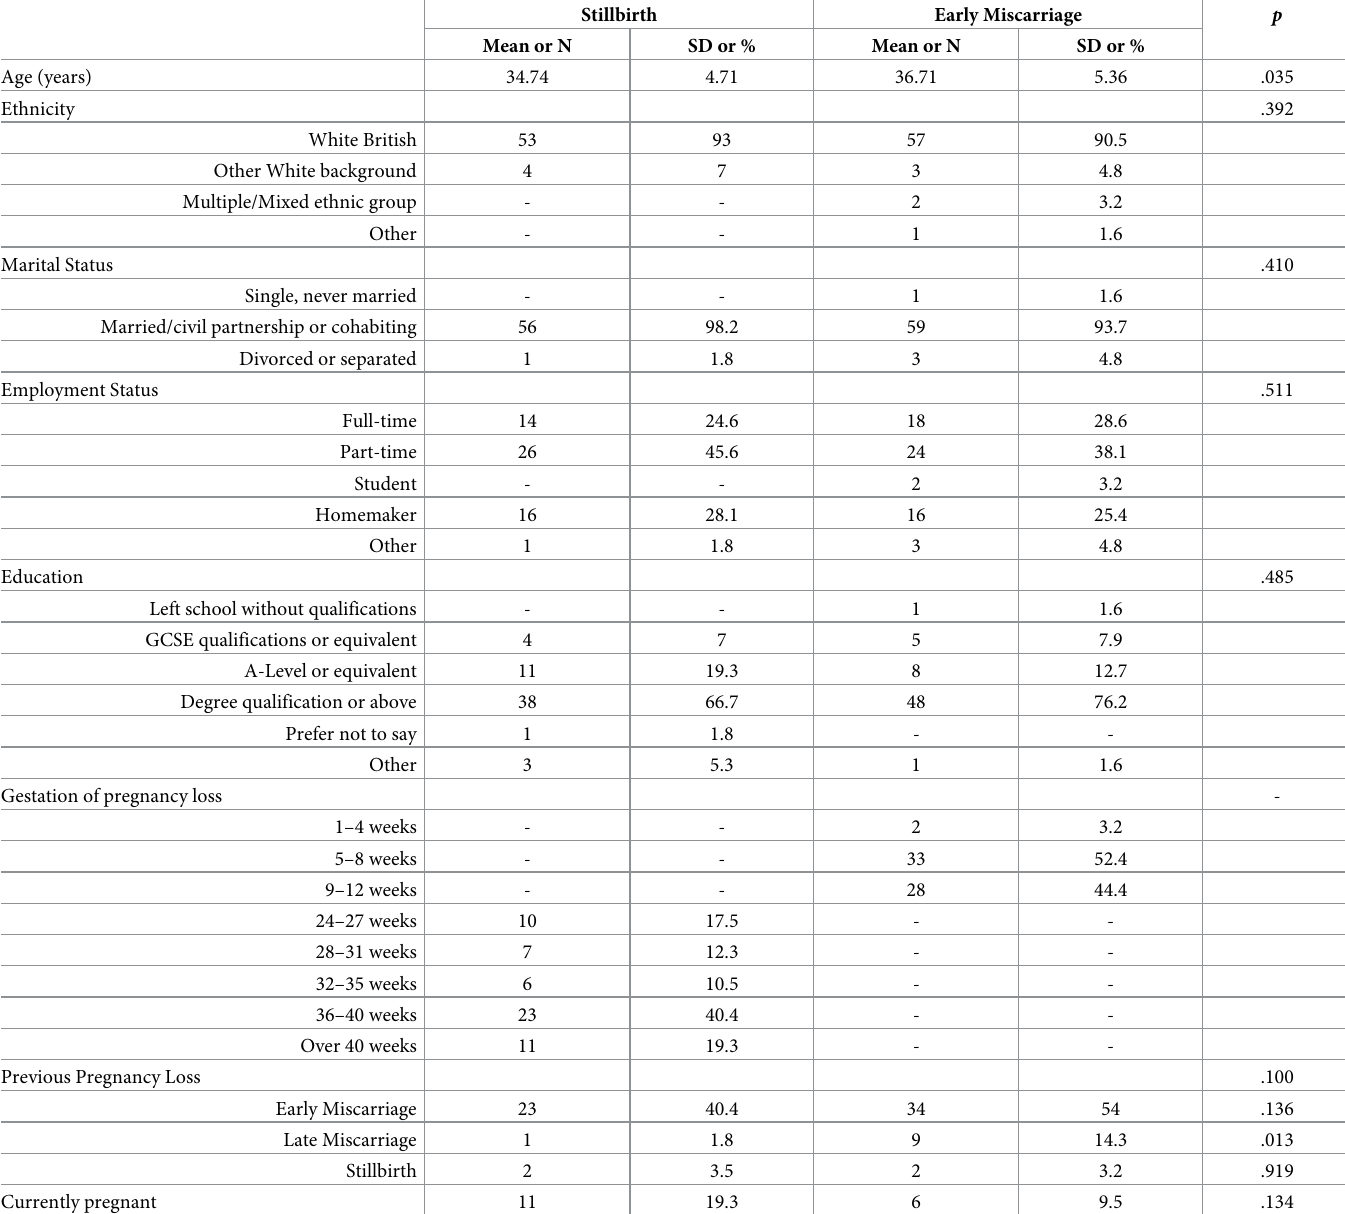
Table 1. Sample characteristics (N =